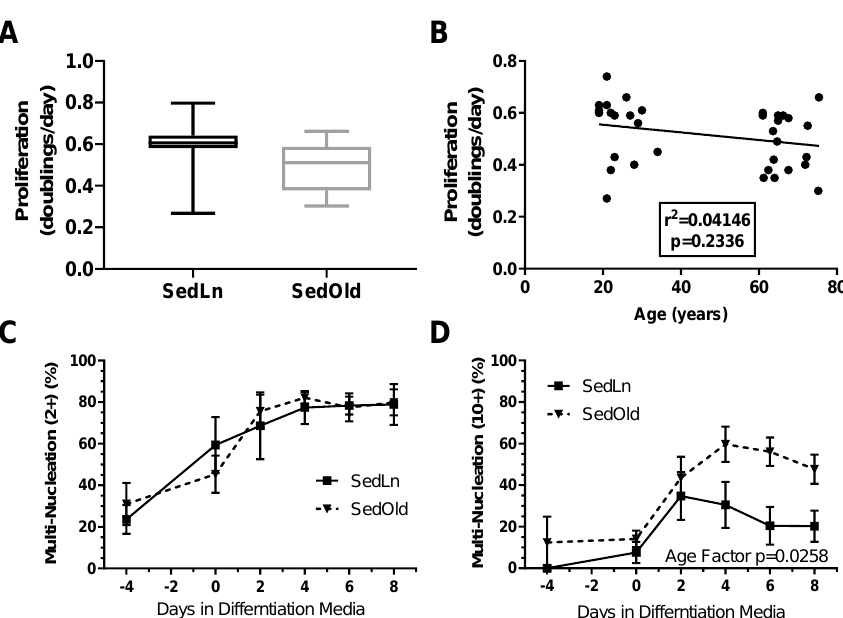
Figure 2. Proliferation rates (doubling/day) of satellite cells (SCs) isolated form sedentary lean (SedLn) ( n = 18, age 19–34 years) and sedentary older (SedOld) ( n = 20, age 61–76 years) participants ( A ). Correlation of SC proliferation rate and donor age ( B ). Fusion index scores (( C ), 2+ nuclei per fiber, ( D ), 10+ nuclei per fiber) of SC from SedLn and SedOld donors. (*, **, *** indicating a p -value of <0.05, <0.01, <0.001, respectively).